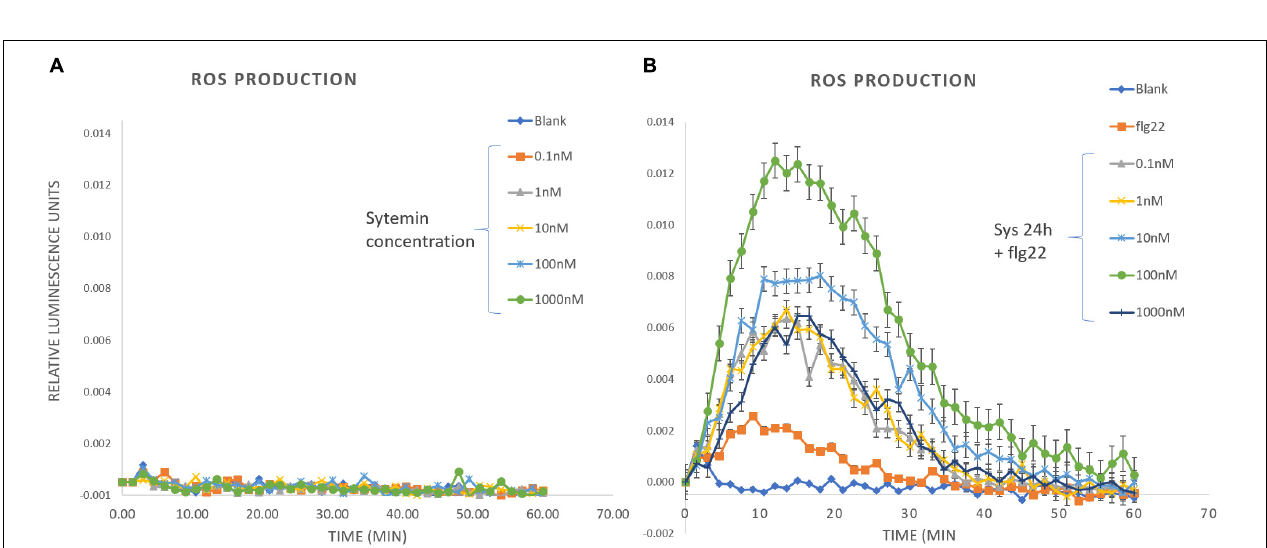
FIGURE 6 | Systemin treatment impact in BAK1 and BIK1 gene expression. Quantitative reverse transcription-polymerase chain reaction (qPCR)analysis of BAK1 and BIK1 in seedlings 48 h after P. cucumerina infection in normal water plants “W,” water infected plants “W inf,” 0.1 nM Systemin treated “Sys” and Sys infected plants “Sys inf” plants. Bars represent mean ± standard error (SD), n = 6. Different letters represent statistically significant differences (ANOVA, Fisher’s Least Significant Difference (LSD) test; P < 0.05, n = 6).